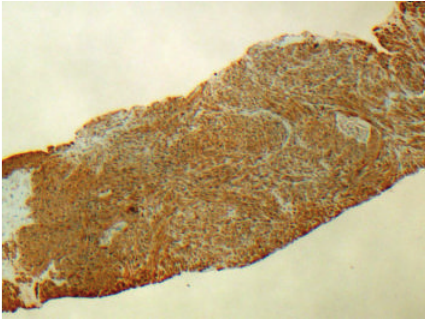
Figure 4: Immunohistochemical study: smooth muscle actin, posi- tive ( × 40 magnification).